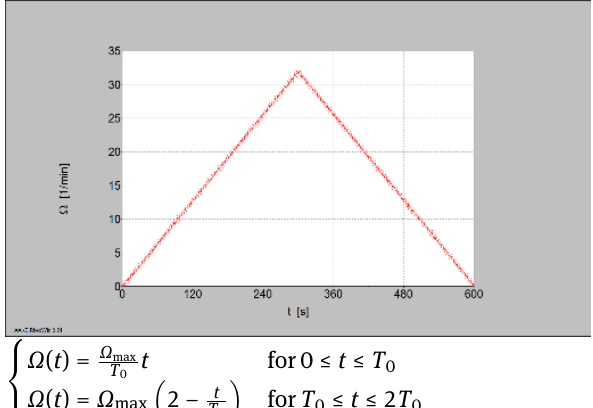
Figure 4: Imposed signal